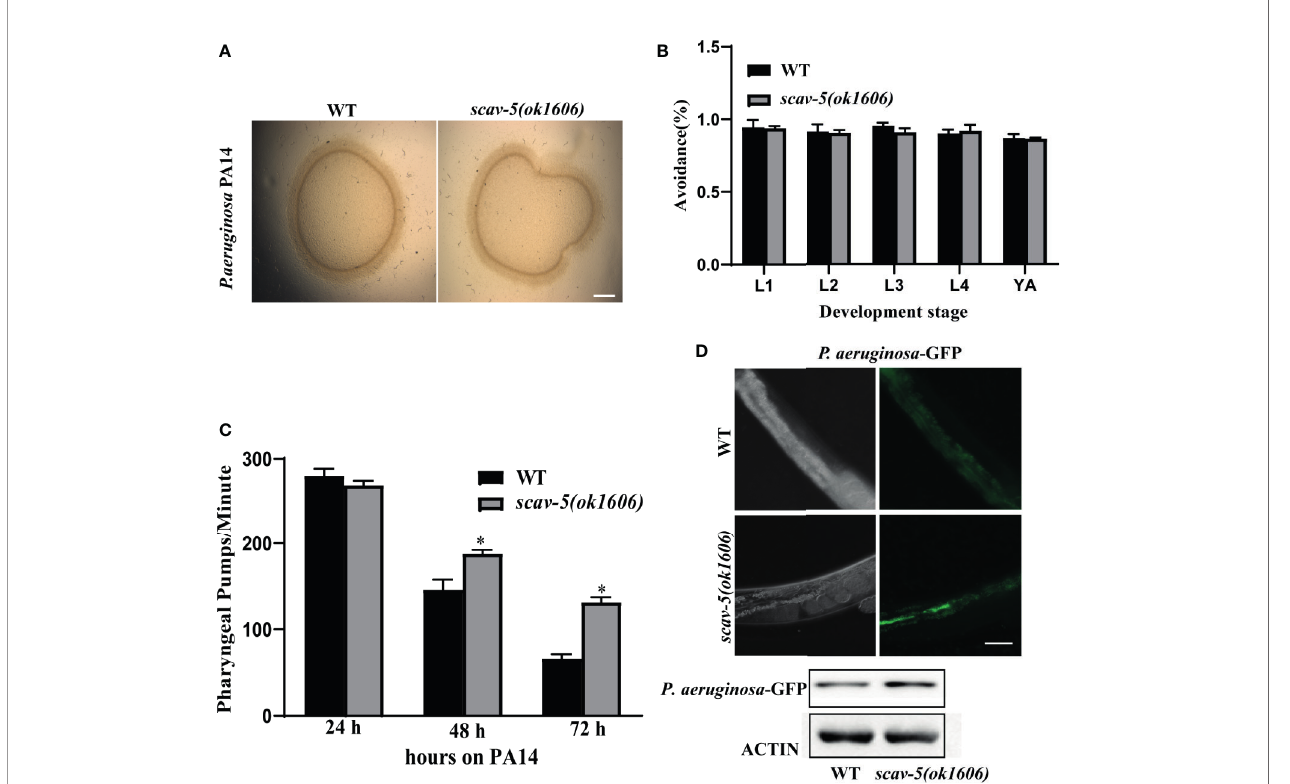
FIGURE 5 | scav-5 mutants do not display dietary restriction when cultured on P. aeruginosa PA14. (A, B) Bright fi eld photographs of wild type and scav-5(ok1606) mutant avoidance from P. aeruginosa PA14 in L4 stage (A) and quanti fi cation of avoidance rate from L1 stage to young adult (B) , Scale bar=100 m m. (C) Statistics of pharyngeal pumps per min of wild type and scav-5(ok1606) mutants fed with P. aeruginosa PA14. (D) The DIC and GFP fl uorescence image of partial intestine in wild type and scav-5(ok1606) mutant cultured on P. aeruginosa PA14-GFP 24 h after L4 stage. And immunoblot analysis of protein from young adult animals fed with P. aeruginosa PA14 24 h using antibodies that recognize the p-PMK-1 and actin. Scale bar=50 m